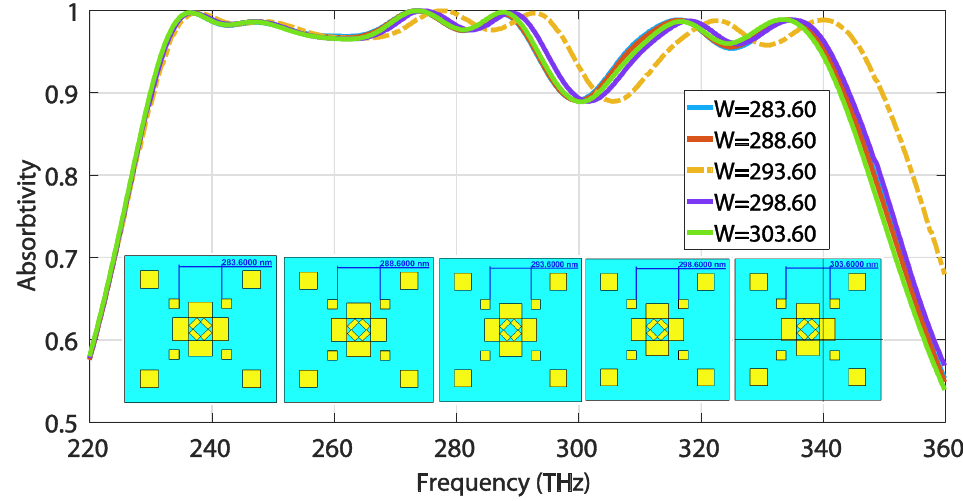
Figure 8. Absorption sensitivity to the lateral distance denoted by W.